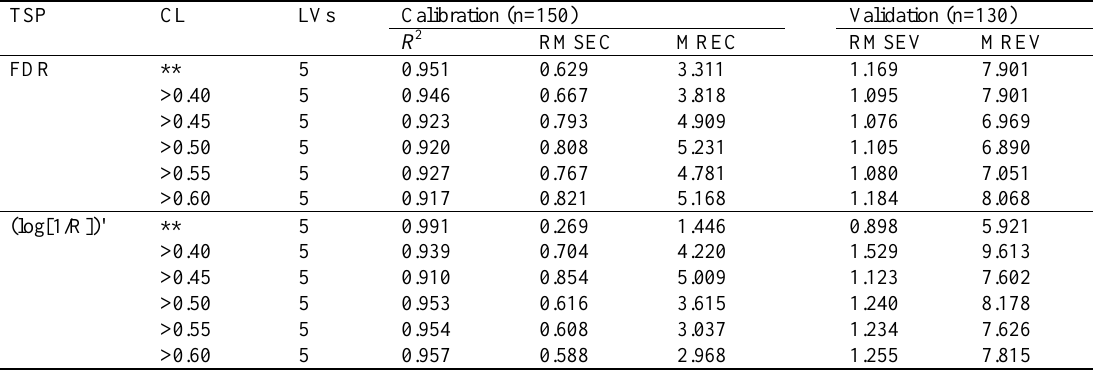
Figure 6. Optimal spectrum (OSP) of the first derivative differential (FDR) (a) and the first derivative differential of reciprocal logarithm (log[1/R])'